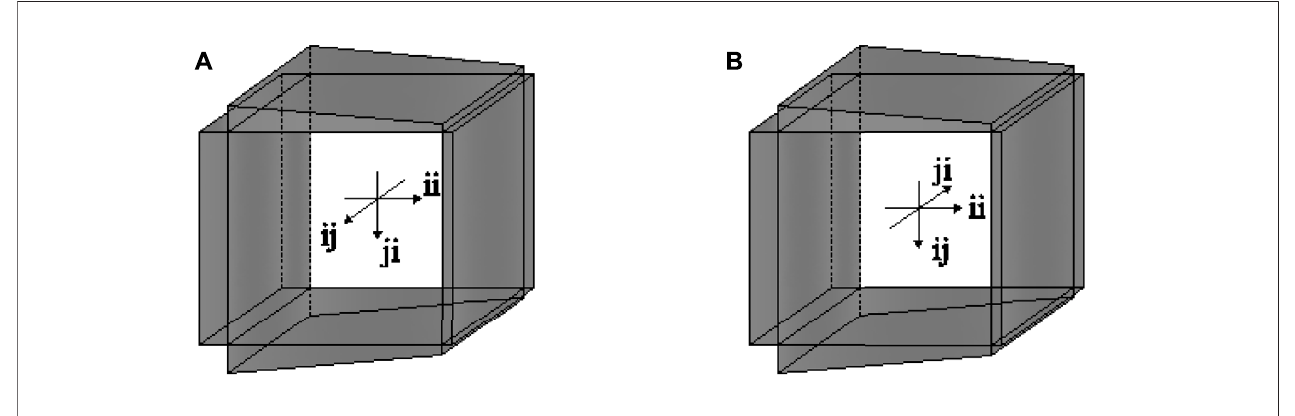
FIGURE 3 | Boundary conditions of a computational